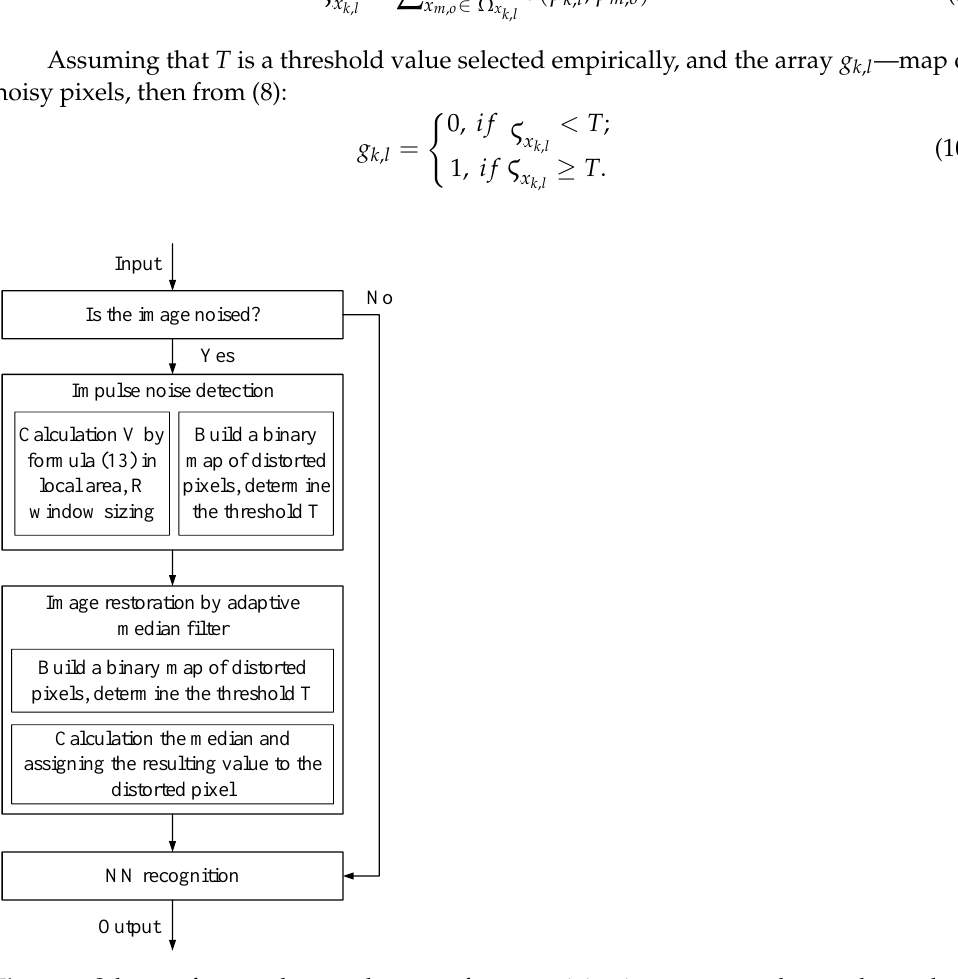
Figure 1. Scheme of a neural network system for recognizing images exposed to random-valued impulse noise.